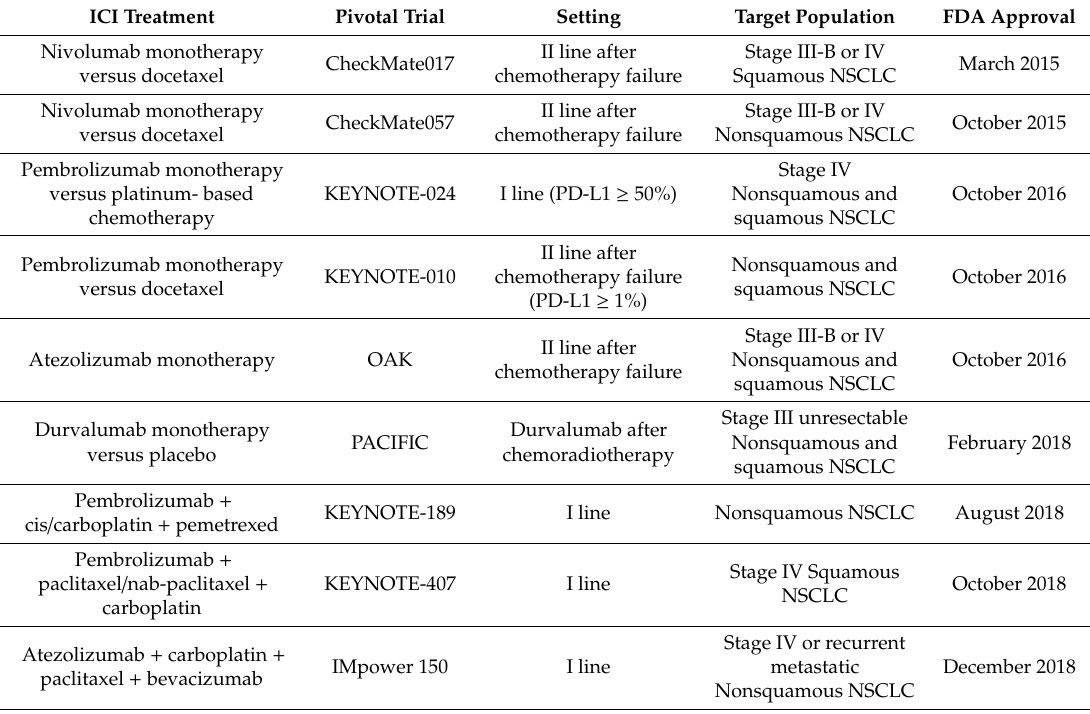
Table 2. FDA-approved immune checkpoint inhibitors (ICIs) for the treatment of stage III / IV NSCLC. ICI